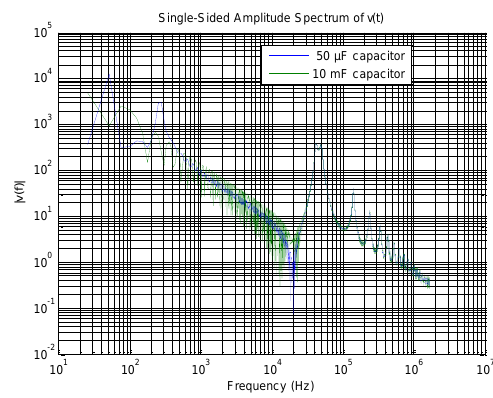
Fig. 26. Effect of capacitor magnitude on the FFT analysis for phase-c secondary.